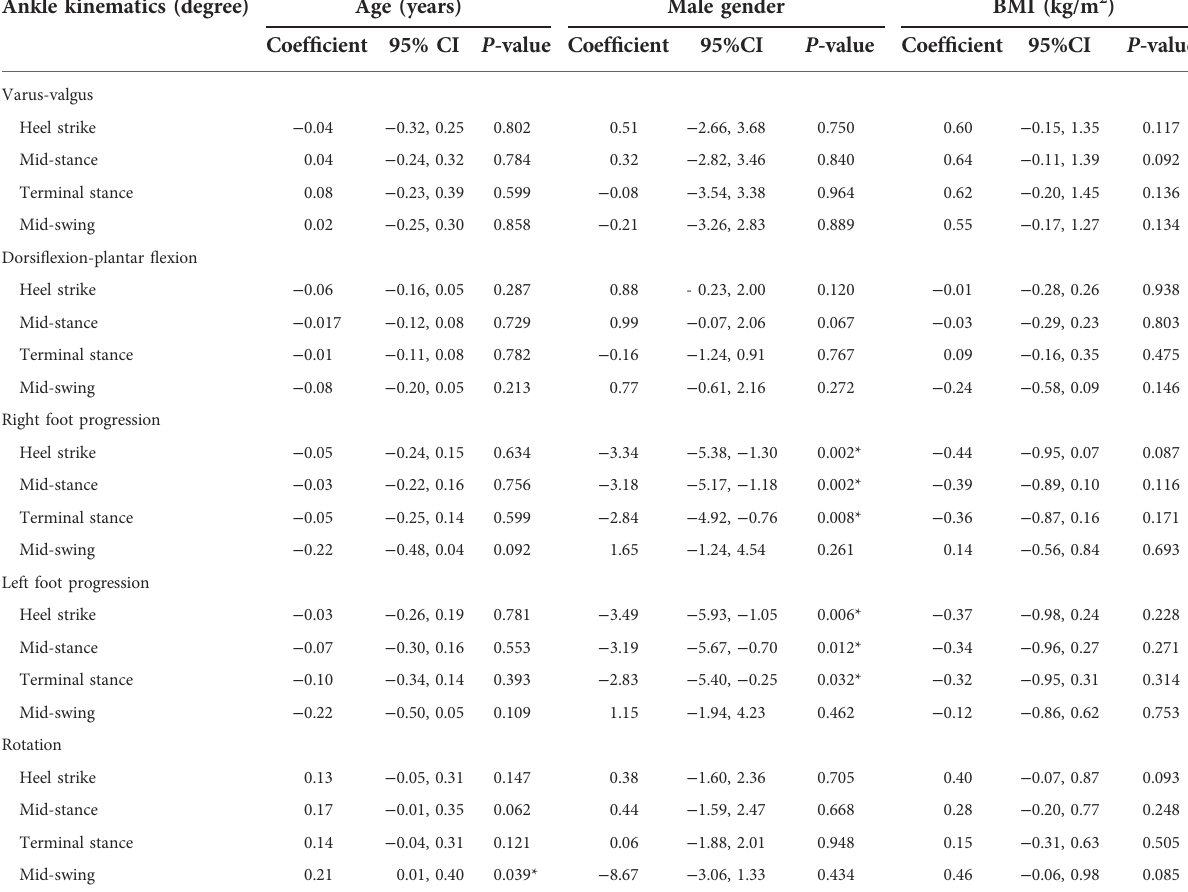
TABLE 4 The relationship between ankle kinematics and age, gender, and BMI. Ankle kinematics